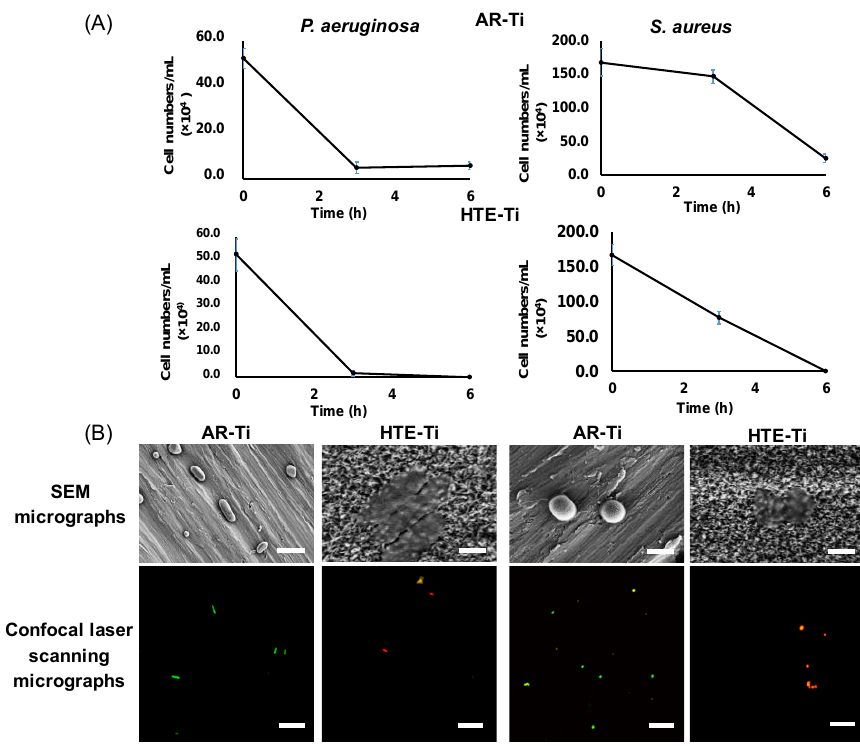
Figure 1. Attachment and viability of P. aeruginosa (left) and S. aureus (right) cells upon interaction with surfaces of smooth control (AR-Ti) and nanostructured hydrothermally treated titanium (HTE-Ti) surfaces. ( A ) Rapid reduction in cell viability confirms bactericidal activity of HTE-Ti against P. aeruginosa (left) and S. aureus (right) over 6 h incubation. ( B ) Representative SEM and Confocal laser scanning microscopy (CLSM) micrographs showing the altered morphology of bacterial cells attached onto HTE-Ti surfaces compared to the normal morphology of cells attached onto AR-Ti surfaces, and presence of live cells (stained green) on AR-Ti and dead cells (stained red) on HTE-Ti surfaces (CLSM Scale bar = 400 nm, SEM scale bar = 1 µm).